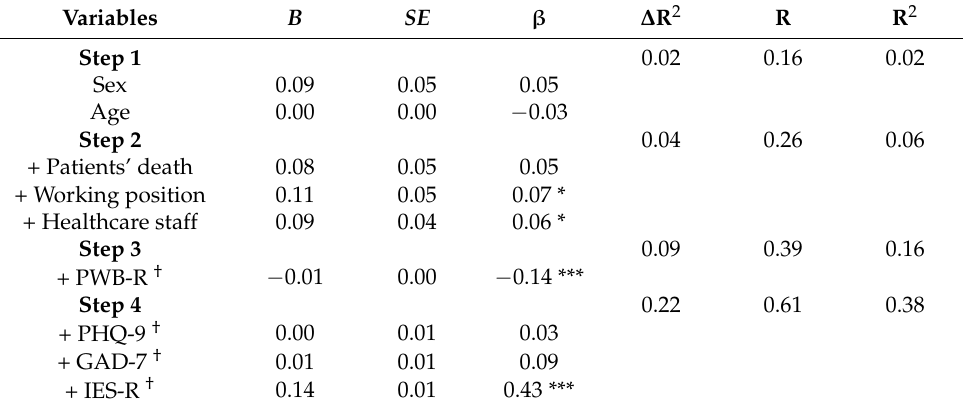
Table 4. Hierarchical regression analysis with burnout total score as a dependent